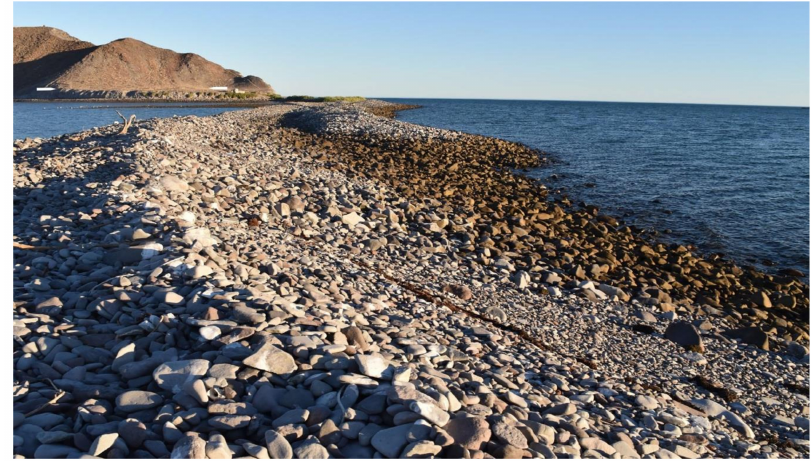
Figure 10. View across transect 4 northeast toward the connection with Isla San Luis Gonzaga, showing a distinct swale between two di ff erent phases of the cobble-boulder deposit. Note the raised Pleistocene marine terrace in the far distance (white arrows). The inner wall of the marine terrace is oriented NS.